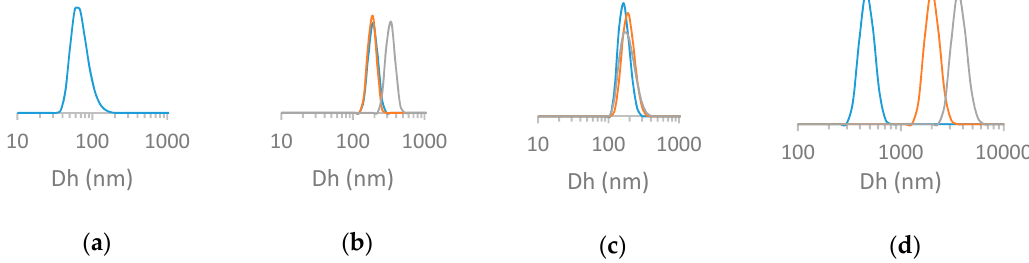
Figure 1. Size (hydrodynamic radius) distribution (in number) obtained by DLS for the SiO 2 ( a ) SiO 2 @NH 2 ( b ) SiO 2 @PW ( c ) and SiO 2 @PMo ( d ) beads. The time dependent size increase (case b – d ) has been indicated by the different colors (blue-orange-grey).